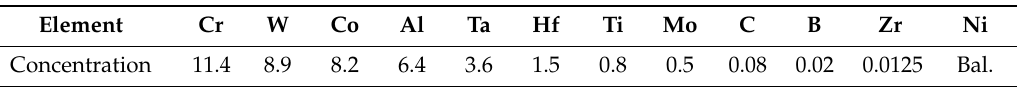
Table 1. Chemical composition of Ren é 108 determined by optical emission spectroscopy (OES), wt%. Element Cr W Co Al Ta Hf